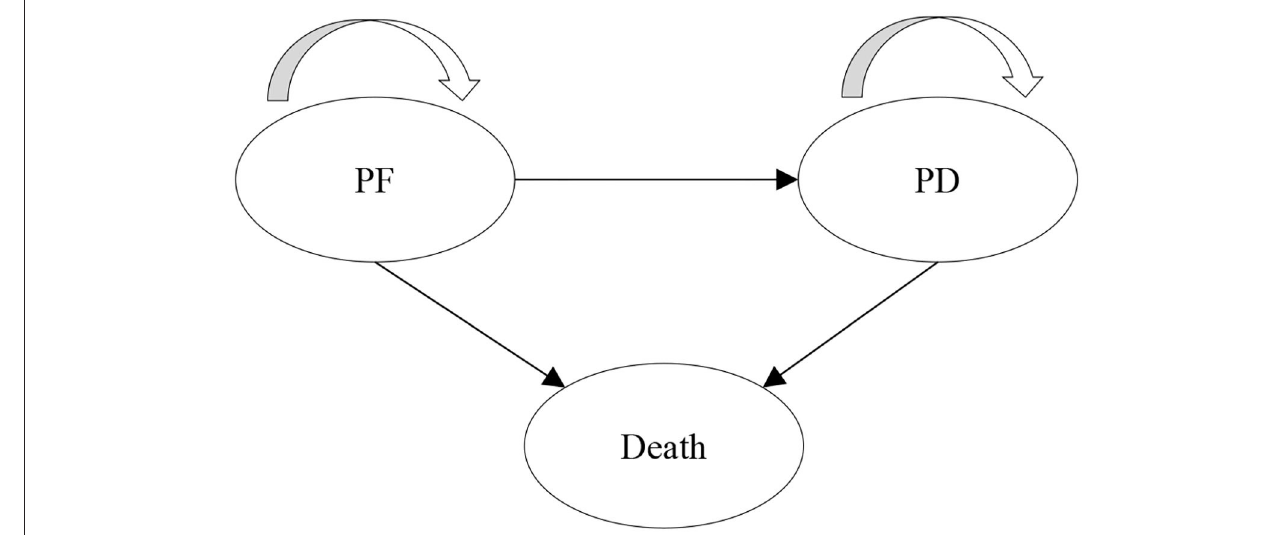
FIGURE 1 | Model structure. PF, progression-free; PD, progressive